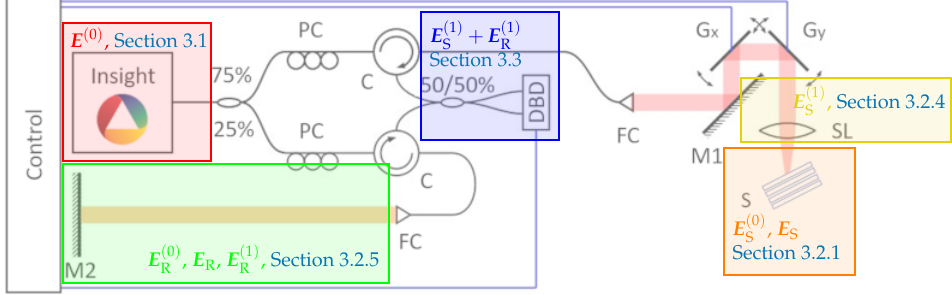
Figure 2. Modeling of the separate parts of the OCT experiment: We start by describing the light beam produced by the laser (the red box) in Section 3.1, we give a representation for the beam in the sample arm which is backscattered from the sample (the orange box) in Section 3.2.1 and is then coupled back into the fiber system via the scan lens (the yellow box) in Section 3.2.4. This is afterwards recombined with the beam from the reference arm (the green box) in Section 3.2.5 and detected by the dual balance detector (the blue box) in Section